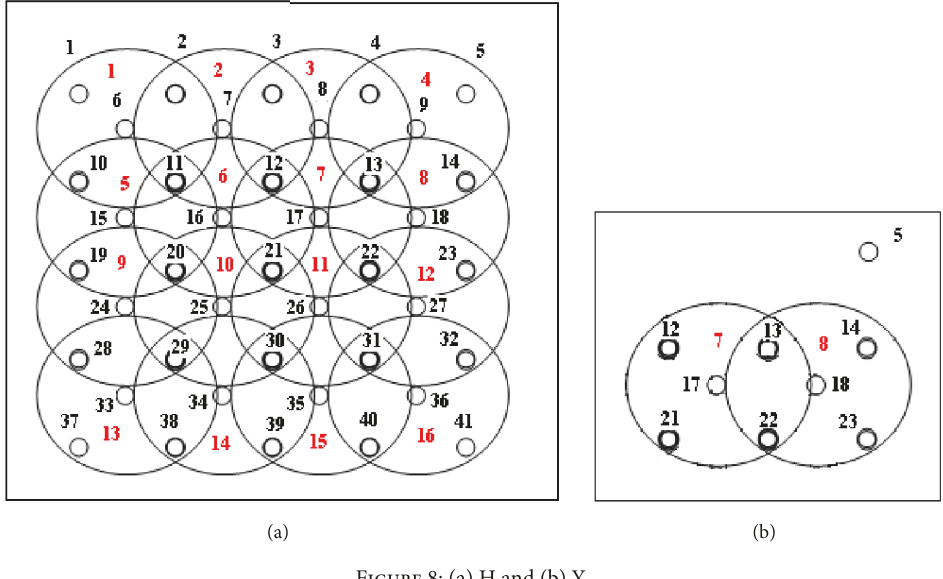
Figure 8: (a) H and (b)